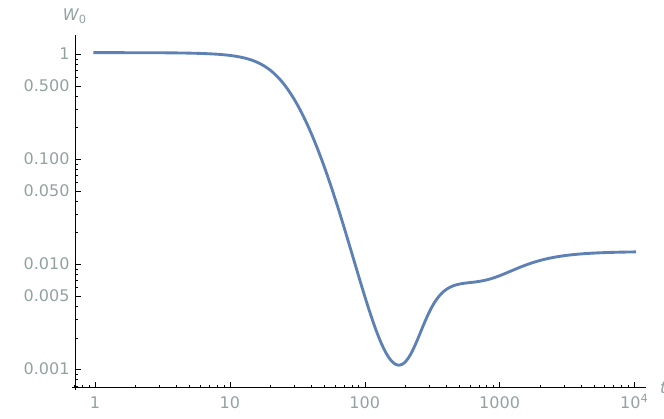
Figure 24 . The out-of-time ordered four-point function in the small (cid:15)